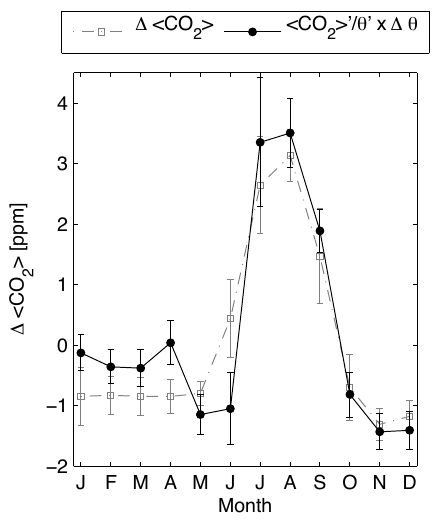
Fig. 11. h CO 2 i contrast between 30 and 60 ◦ N over North America (averaged between 180 and 300 ◦ W). The gray squares are the ac- tual contrast, while the black circles are the contrast calculated from variations in h CO 2 i and θ .